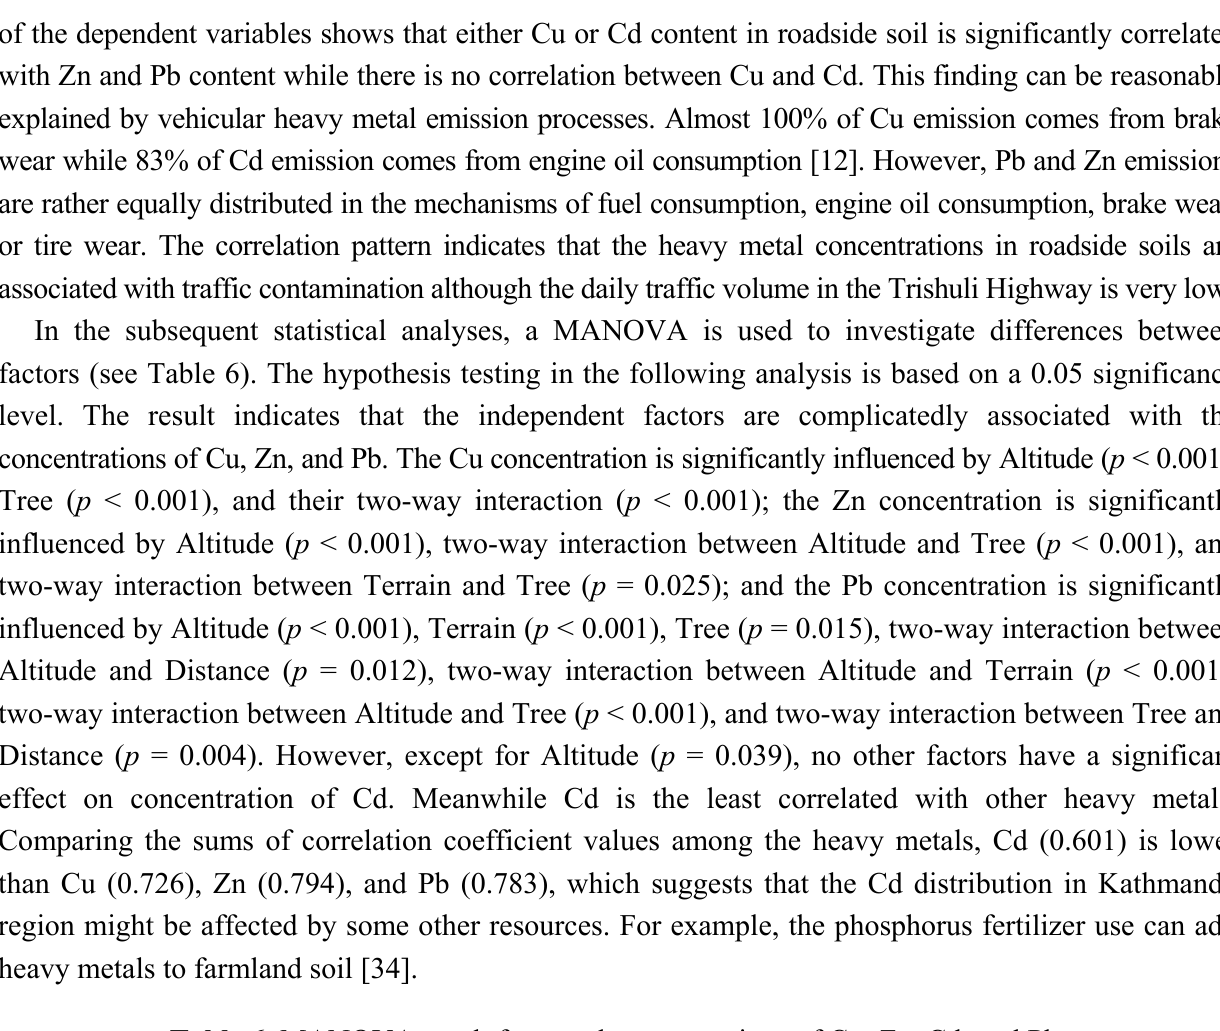
Table 6. MANOVA result for metal concentrations of Cu, Zn, Cd, and